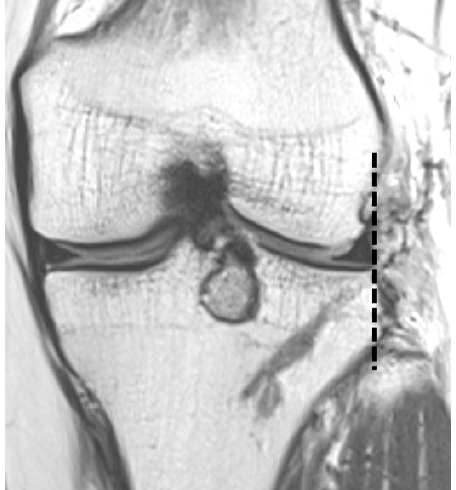
Figure 6. Graft extrusion on the coronal plane is defined as the distance between the lateral margin of the graft and the superolateral aspect of the tibial plateau. There is no graft extrusion.